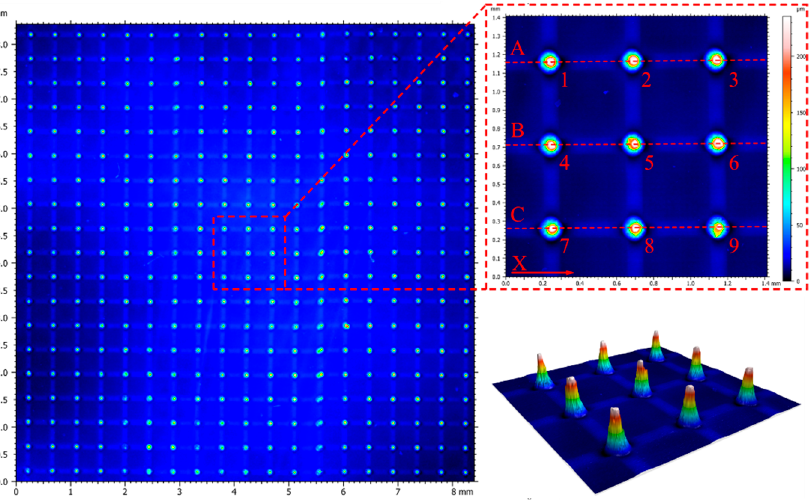
Figure 5. Emitter array surface topography measurement results.